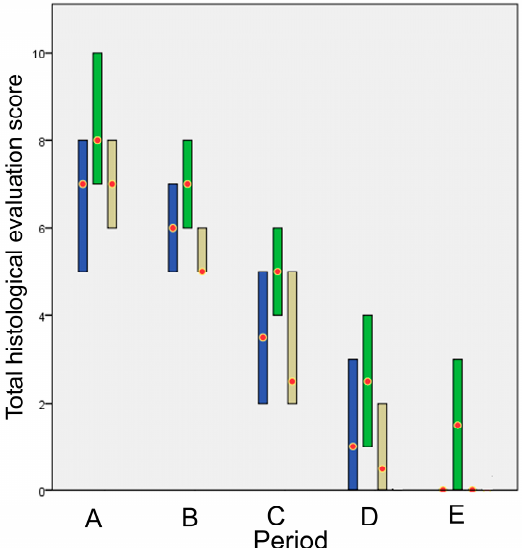
Figure 17. Median (red dot) and interquartile range (column) of the score of total histological eval- uation for each technique (blue: staples, green: glue, gray: intradermal) in each period. [period A: 1–8 po.d.; period B: 9–21 po.d.; period C: 22–63 po.d.; period D: 64–180 po.d.; period E: 181–365 po. d]. In all periods no significant differences were observed between the techniques (all p > 0.043).